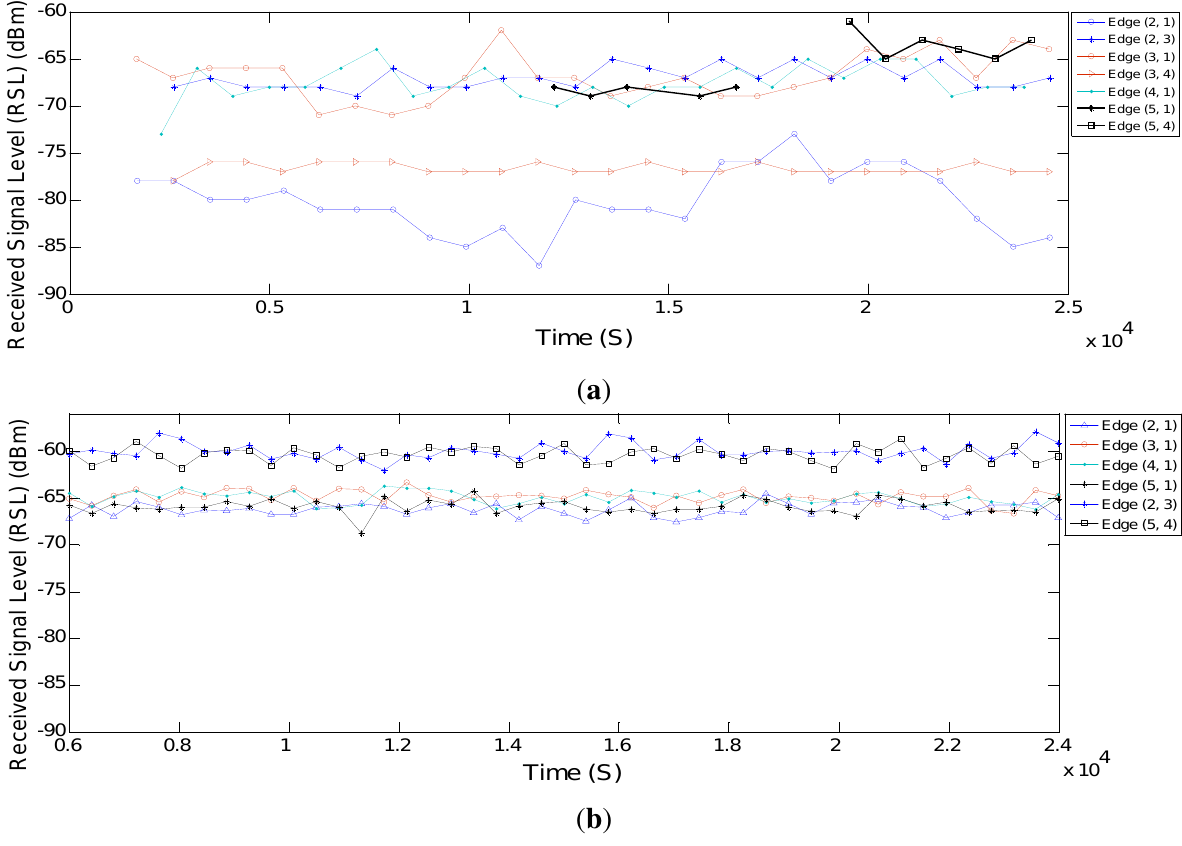
Figure 14. The average of receive signal level (RSL) on different edges in the network over time ( a ) for a real network and ( b ) for a simulated